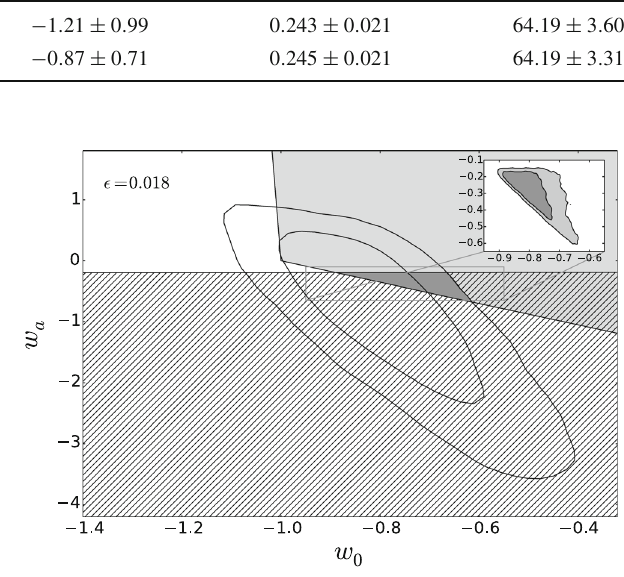
Table 2 Constraints on the cosmological parameters for P1 and P2 considering a flat prior for each parameter (cid:7) w o